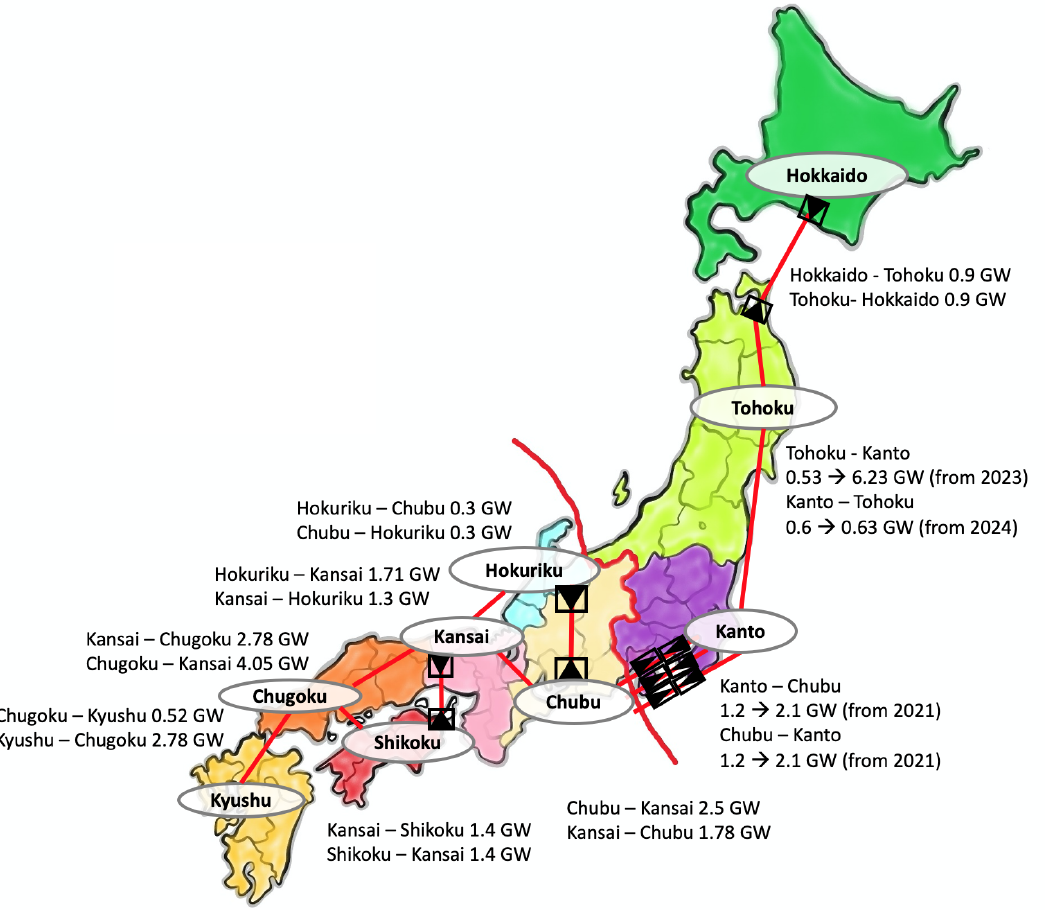
Figure 2. The 10 Japanese Electricity Power Companies (EPCOs)’s regional service areas. The capacity of the grid connection between the various regions is also provided between them, with DC lines marked by triangles and AC lines without (Transmission capacity data based on: [86]). The dates inside the brackets indicate when the increased capacity should be available. Note that archipelago of Okinawa is not connected to the four main islands of